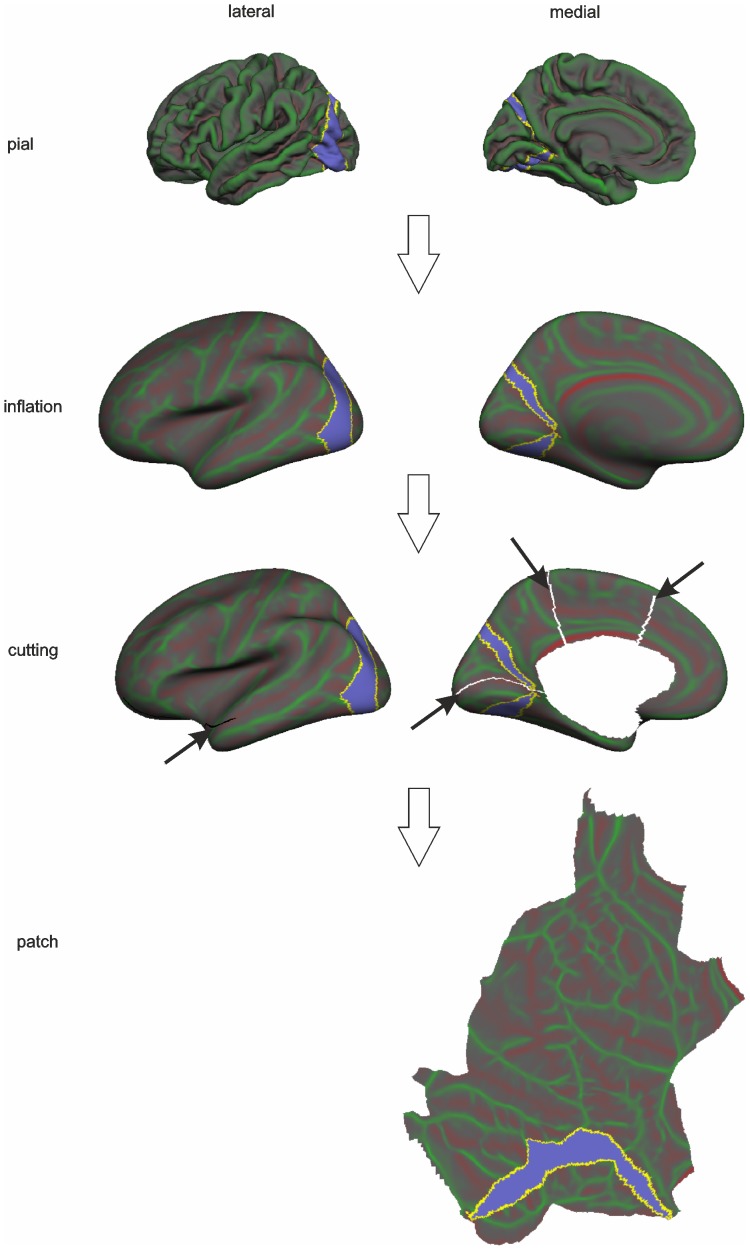
A surface processing pipeline leading to flat maps of the pial surface.A pial surface stored as a triangular mesh was first inflated, then a cortical patch was prepared by removing PCC and making cuts in order to create flat maps of the pial surface. The violet ROI includes Brodmann's 17 area corresponding to primary visual cortex (V1). This is shown for illustration purposes.